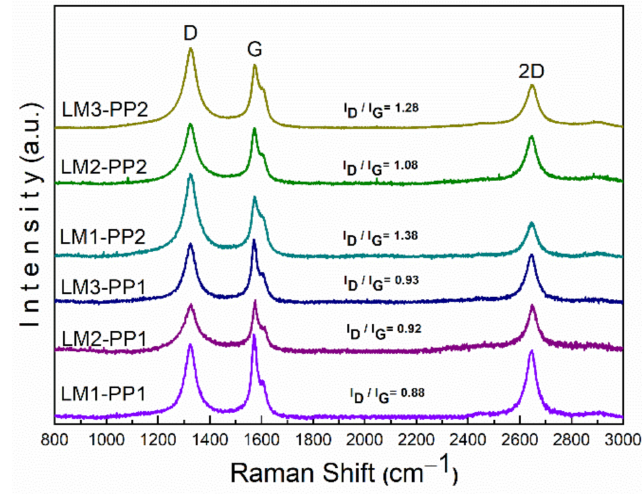
Figure 7. Comparative Raman spectra of PP1 and PP2 leached samples.